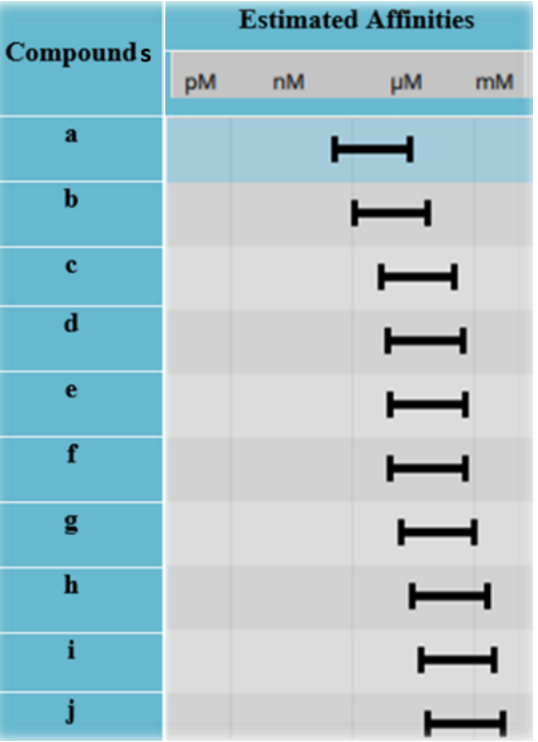
Figure 8. Estimated affinities of best hits. According to the estimated affinities, compound a shows the highest estimated affinity (via SeeSAR) than others.